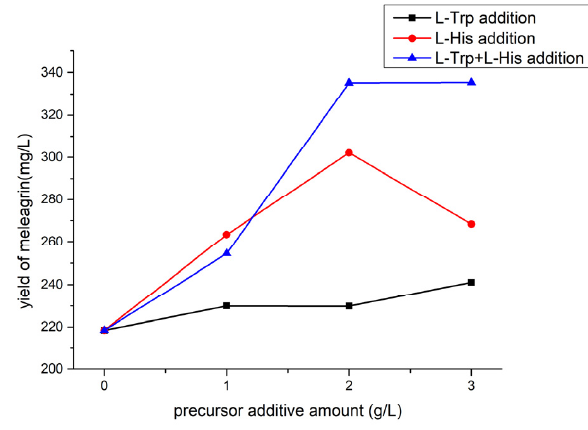
Figure 13. The yield of adding different meleagrin precursors.